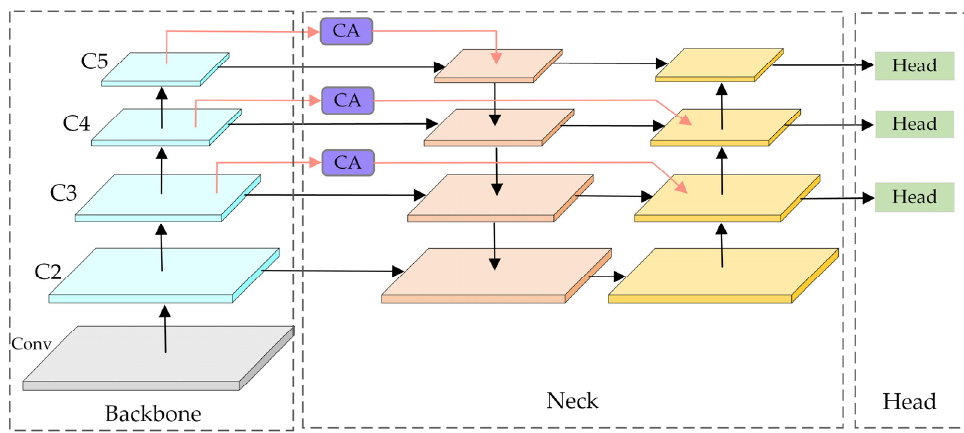
Figure 4. The overall structure of IPD-Net.